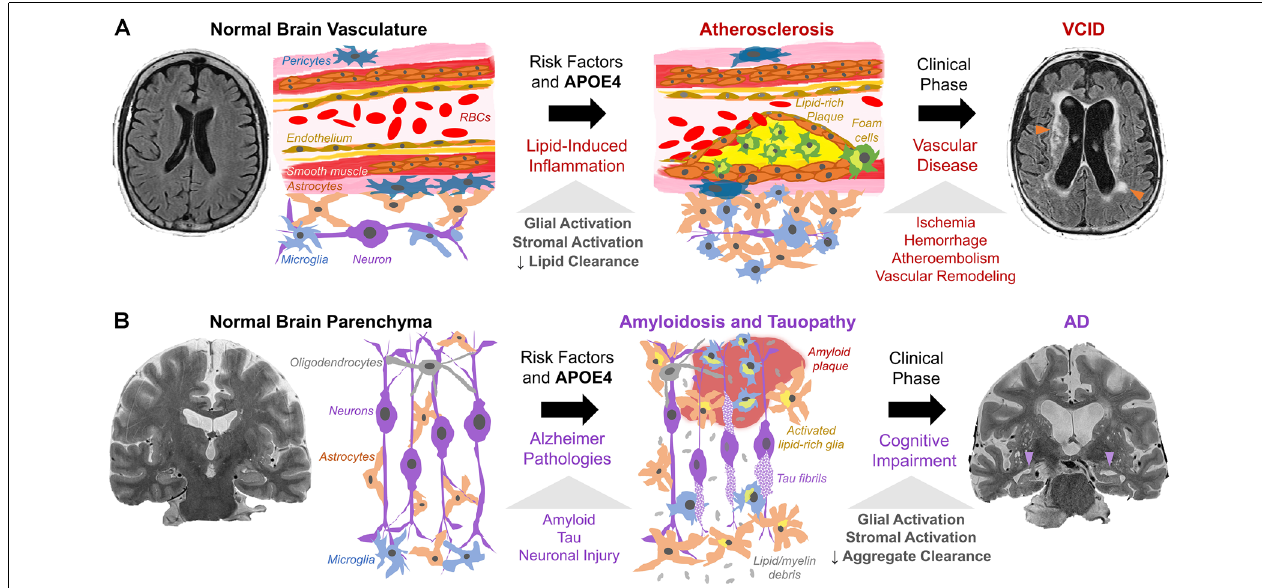
FIGURE 2 | Working model of cholesterol, APOE4, and stromal activation in ( A ) VCID and ( B ) AD. ( A ) Risk factors (hypercholesterolemia, hypertension, smoking, APOE4) trigger atherosclerosis via cholesterol-rich plaques with local/systemic inflammation and stromal dysfunction (glia, macrophages, smooth muscle, endothelium, pericytes). Lipid-induced inflammation impairs lipid turnover and exacerbates plaque formation. This leads to ischemia (arrowheads) and dementia as detected by fluid-attenuated inversion recovery MRI. ( B ) Amyloid and tau pathology, with risk factors and APOE4, trigger neuronal injury. Subsequent proteinopathy-associated glial activation and lipid deposits (from glial proliferation and myelin debris) hinder amyloid/tau aggregate clearance and promote accumulation. This leads to aggregate spread and neurodegeneration (arrowheads) as seen on T2-weighted